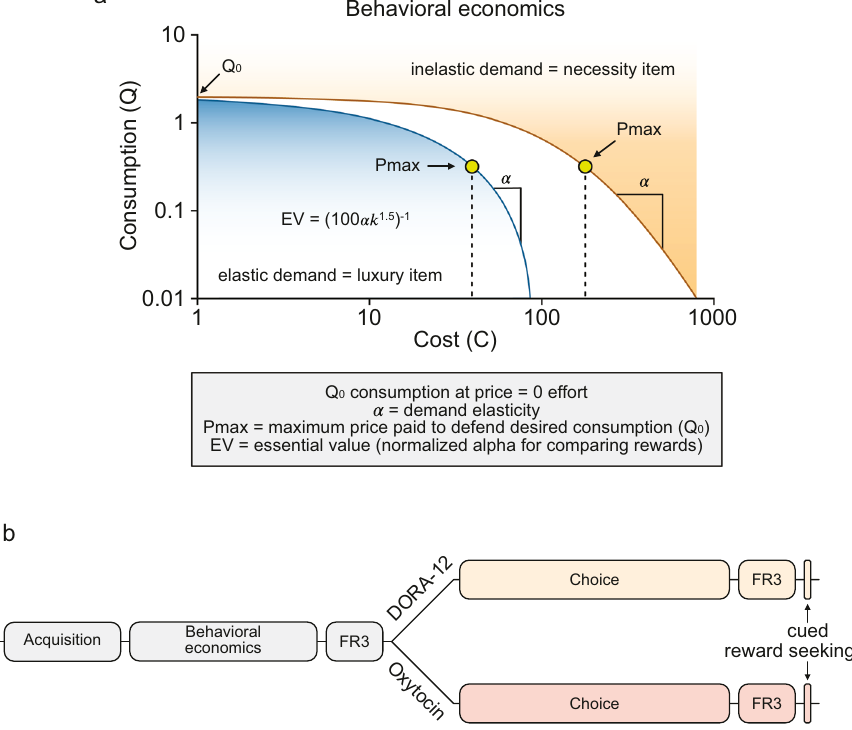
Fig. 1 Behavioral economics principles and experimental timeline. a Example of “ elastic ” and “ inelastic ” demand curves and de fi nition of the behavioral economic parameters analyzed in the present study (gray box). b Experimental timeline for heroin and food self-administration, behavioral economic, choice testing and cued relapse. Animals where trained to self-administer food (30 min) and heroin (2 h) in tandem for 8 sessions (FR1), followed by 8 additional fi xed-ratio steps used to extract behavioral economics variables. After 3 days of self-administration under FR3 schedule, animals where split into two different treatment groups (DORA-12 and Oxytocin) and entered the choice phase. At the end of choice testing, animals received 3 days of food and heroin self-administration under FR3 schedule before being tested in the cued reward seeking